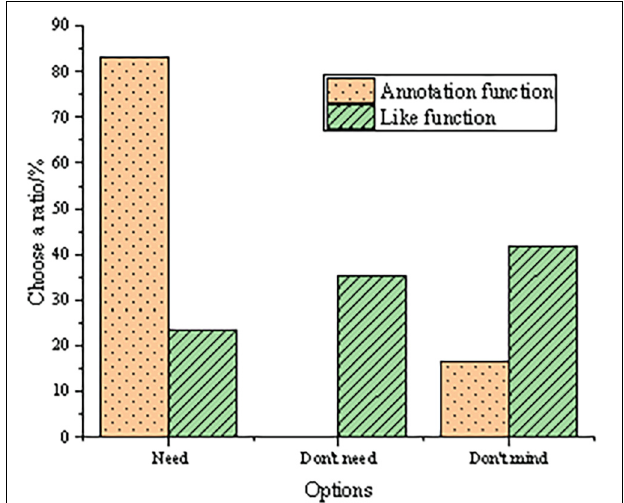
FIGURE 9 | Survey results of the interactive function of video